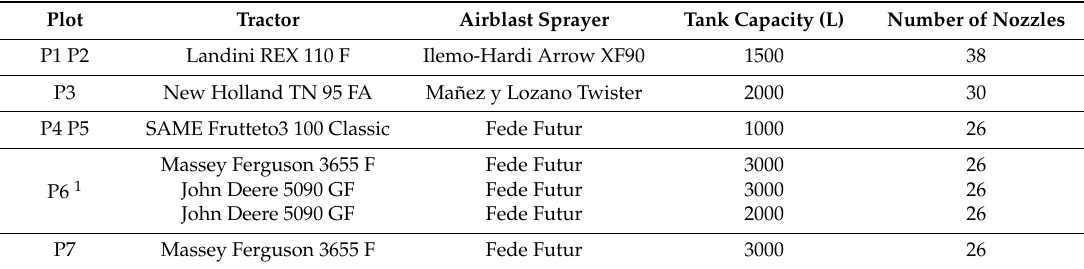
Table 2. Tractors and sprayers used in the applications.